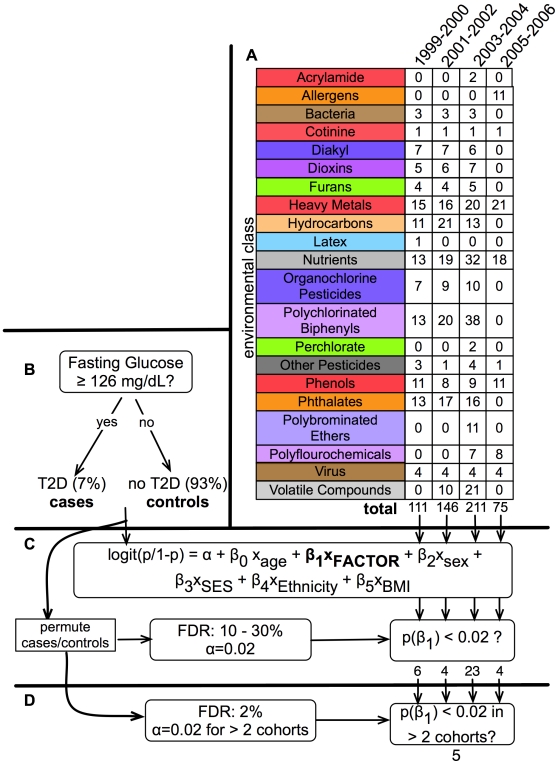
Summary of EWAS Environment Factors and Analytic Method.A.) Summary of the 21 factor classes and the number of factors within them for each NHANES cohort. B.) Individuals were stratified into T2D status (“cases” and “controls”) through the ADA FBS threshold for diabetes diagnosis. 6–7% of the unweighted observations in all cohorts had T2D under this rule. C.) Each of these 75 to 211 factors was tested for association with T2D status with a logistic regression model (coefficient labeled “FACTOR”) adjusted for age, sex, BMI, ethnicity, and SES. Statistical significance (α = 0.02) was determined by controlling the FDR between 10 to 30%. Between 4 and 23 factors were found to be significant using this threshold α = 0.02. D.) “Multi-stage” validation. For factors that were deemed significant in C, we deemed a factor validated if the factor was significant to the α = 0.02 level in one or more of the other cohorts. We found 5 factors to be validated (FDR of 2%).